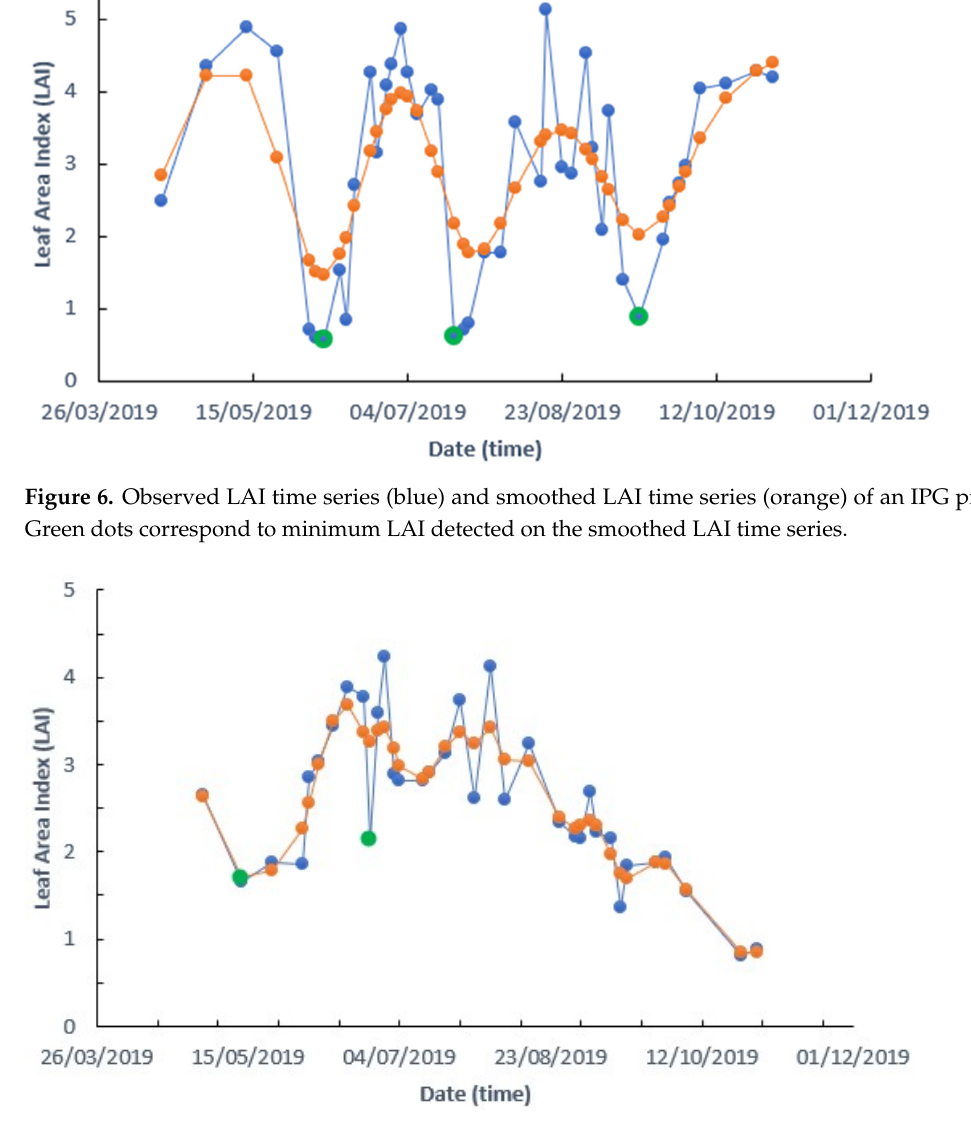
Figure 7. Observed (blue) and smoothed (orange) LAI time series of a NIG pixel detected as an IPG. The green dots correspond to the detected mowing events using the developed algorithm after the first phase of calibration.